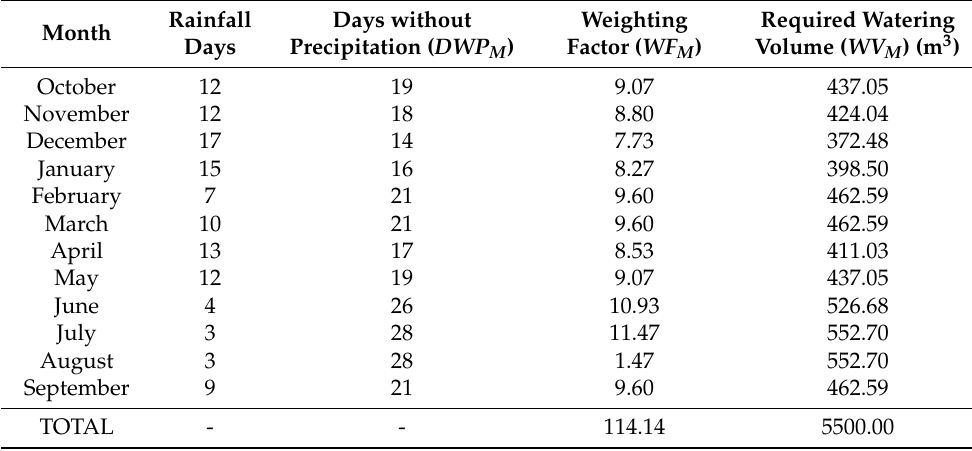
Table 2. Monthly consumption for irrigation estimated for an average